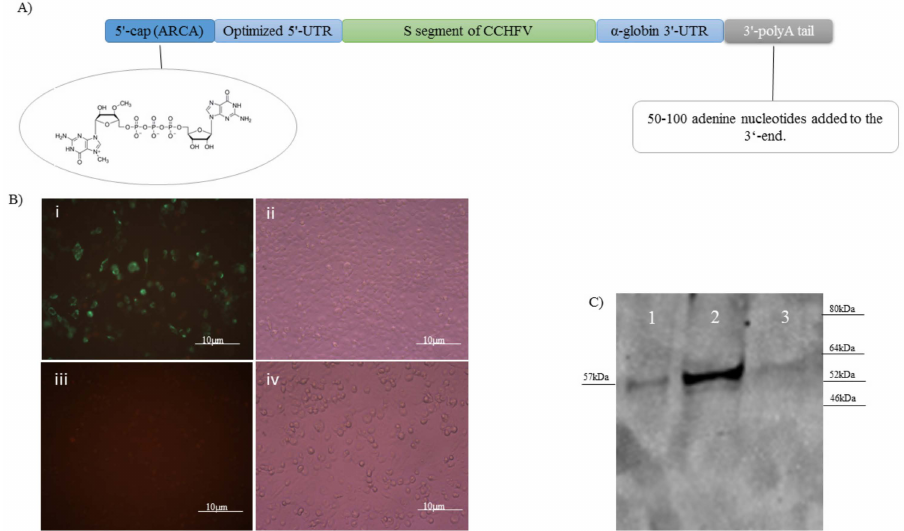
Figure 1. ( A ) Genomic structure of naked conventional mRNA expressing the non-optimized S segment of the Ank-2 strain of CCHFV. To guarantee the stability of the structure, a 5 (cid:48) -cap, 3 (cid:48) -poly A tail, and 5 (cid:48) and 3 (cid:48) -UTR were added. ( B ) The created mRNA vaccine construct was transfected in the BHK21-C13 cells and in vitro expression was verified by IIFA ( × 40): ( i ) fluorescence; ( ii ) phase contrast. We also included negative control cells as the background in the assay: ( iii ) fluorescence; ( iv ) phase contrast. ( C ) Expression of the His-tagged nucleocapsid protein in the bacterial system was analyzed by western blot assay. As became obvious after overnight IPTG induction of BL21 bacteria containing pET-N13, a strong band of 57 kDa (lane 2) was detected in the WB. As a control, we included the supernatant from the IPTG induced (lane 1) and the lysate from the non-induced bacteria containing the pET-N13 construct (lane